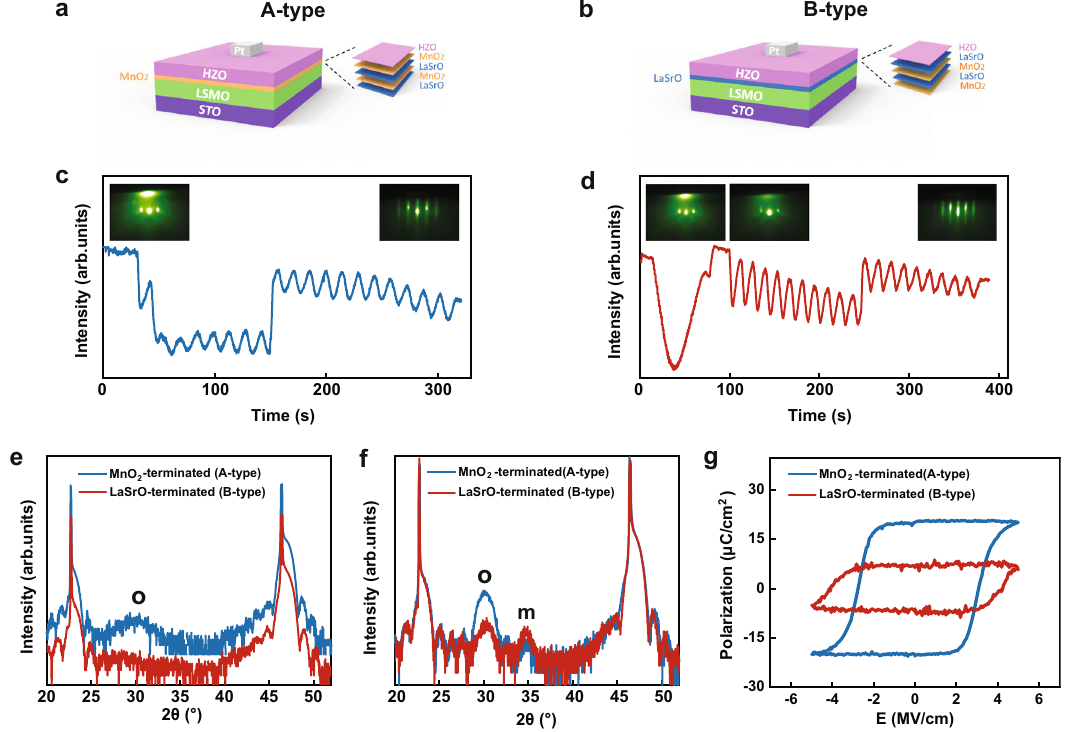
Fig. 1 | RHEED, XRD characterization, and ferroelectric characterization of A- and B-type HZO/LSMO heterostructures. a , b Schematic of the A-type (HZO/ MnO 2 )terminatedandB-type(HZO/LaSrO)terminatedstructure.Theatomicplane sequences across the HZO/LSMO interfaces are indicated. c , d RHEED intensity oscillations of the specularly re fl ected beam during the growth of A-and B-type structure. The insets indicate the RHEED patterns before and after the growth of